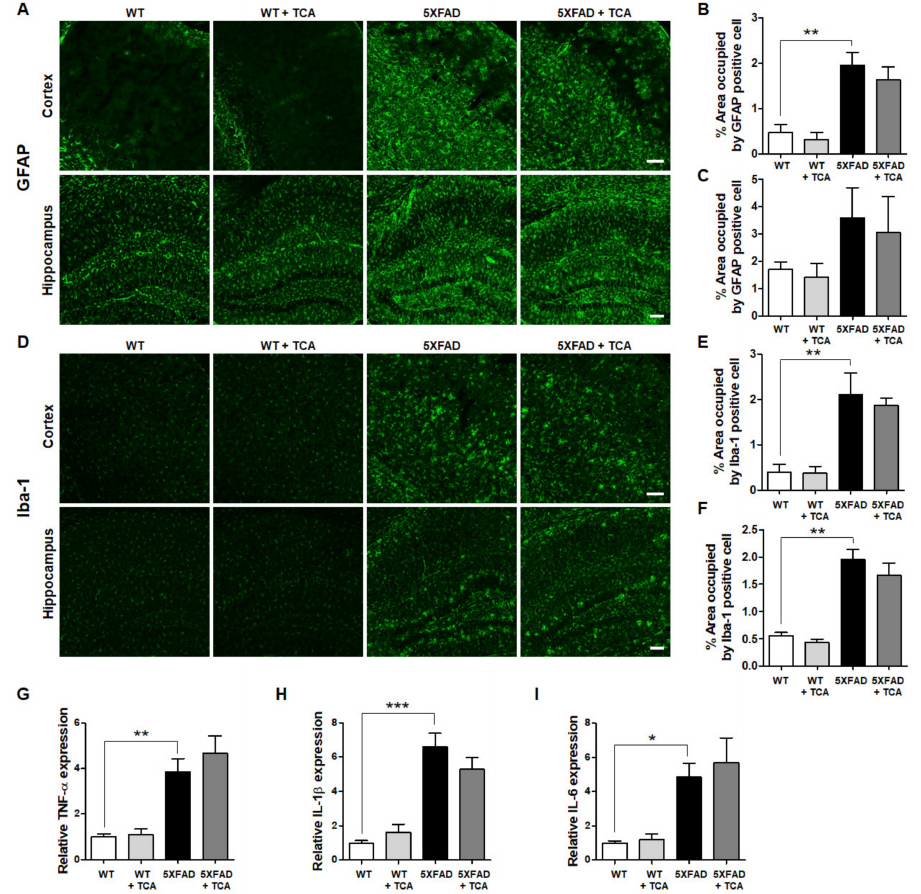
Figure 5. TCA does not a ff ect inflammatory responses in the brains of 5XFAD. ( A ) Representative immunofluorescence images of glial fibrillary acidic protein (GFAP)-positive cells in the brains of